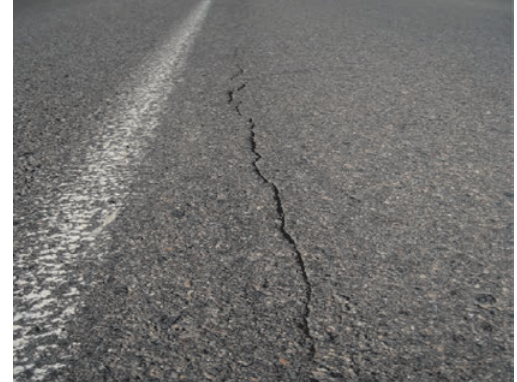
Fig. 10. Longitudinal cracking caused by construction technology